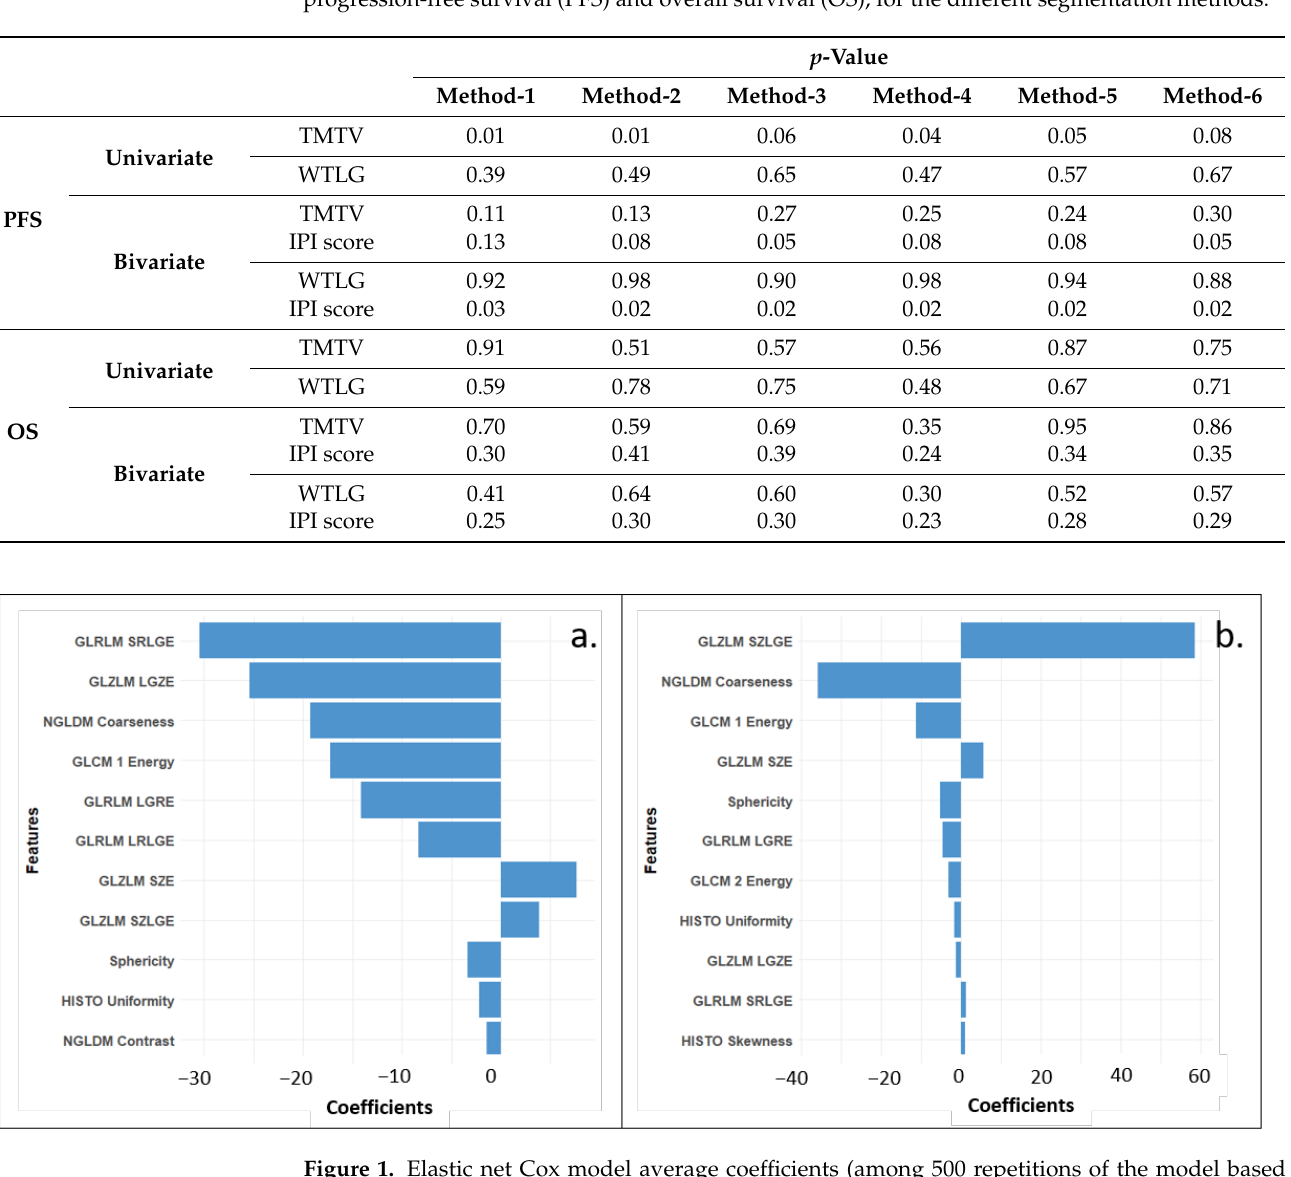
Figure 1. Elastic net Cox model average coefficients (among 500 repetitions of the model based on a bootstrap resampling) for prediction of ( a ): PFS and ( b ) : OS according to RFs extracted from “SU- on a bootstrap resampling) for prediction of ( a ): PFS and ( b ): OS according to RFs extracted Vmax lesion” segmented with Method -2. Only coefficients larger than 1.00 are represented.